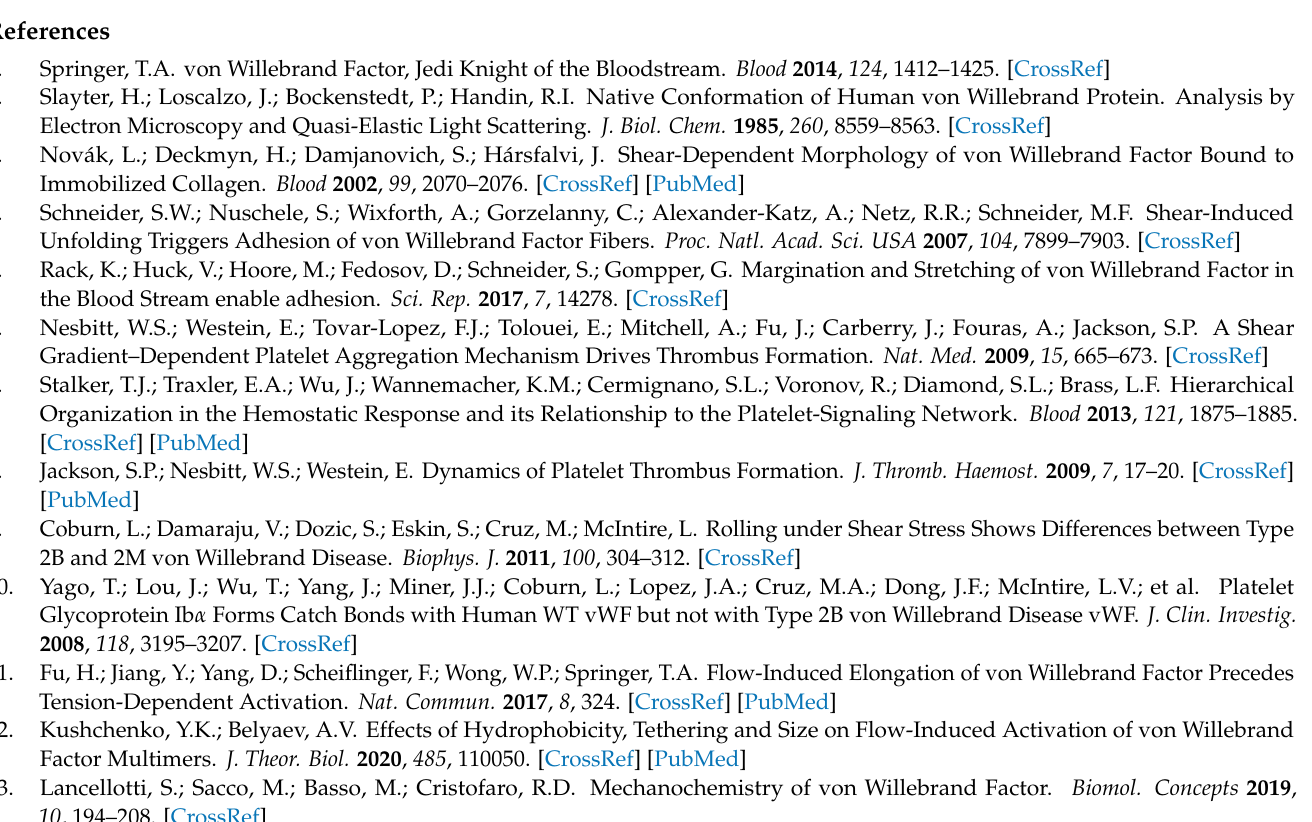
A1A2A3 under shear. Figure S3: Exposure of the cleavage and the recognition sites of A2 domain. Figure S4. Unfolding path of the A2 domain under shear. Figure S5: Extension of the A2 domain within the A1A2A3 construct under shear. Figure S6: A1A2A3 under shear. Figure S7: Effective load force on A2 terminals. Figure S8: Effective load force on A2 terminals. Figure S9: A1A2A3 rotation under shear. Figure S10: A1A2A3 collapse/extension